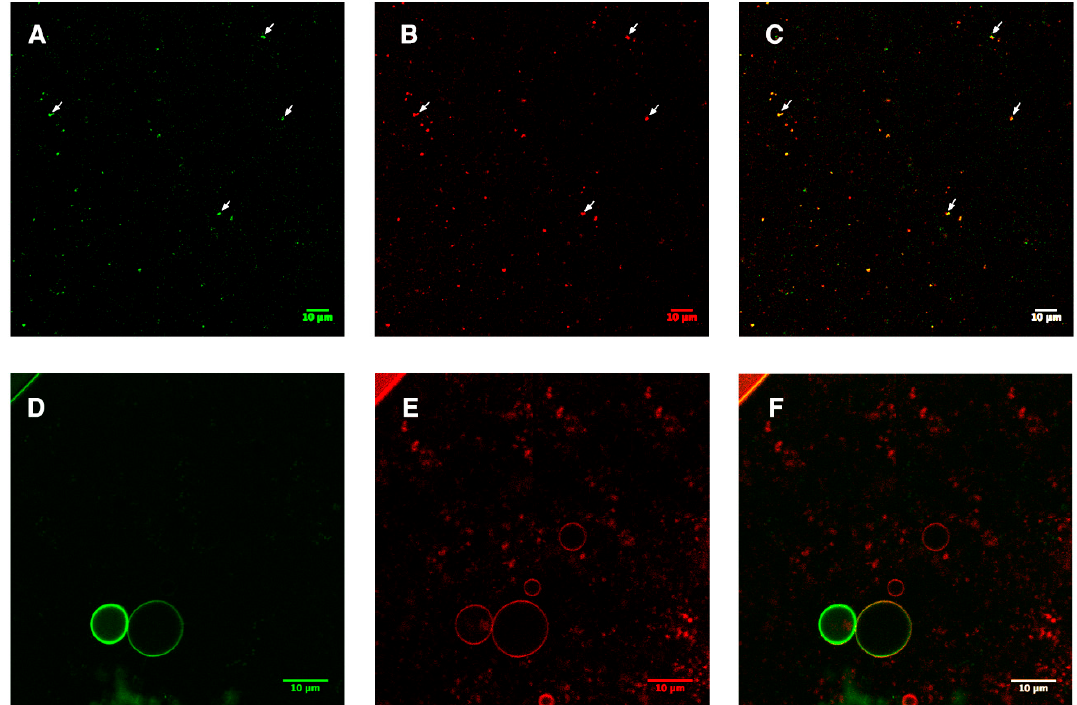
Figure 4. Monitoring the insertion of AqpZ-sGFP after reforming of the proteo-liposome. sGFP and lipids (stained via Nile red) are shown in green and red; a merged image is shown in C and F. ( A – C ), representative sample of the AqpZ-sGFP proteo-liposome formed after removal of detergents either via dialysis or bio-beads. The white arrows indicate the position of co-localized signals. ( D – F ), GUVs formed via fusion of AqpZ-sGFP proteo-liposome.